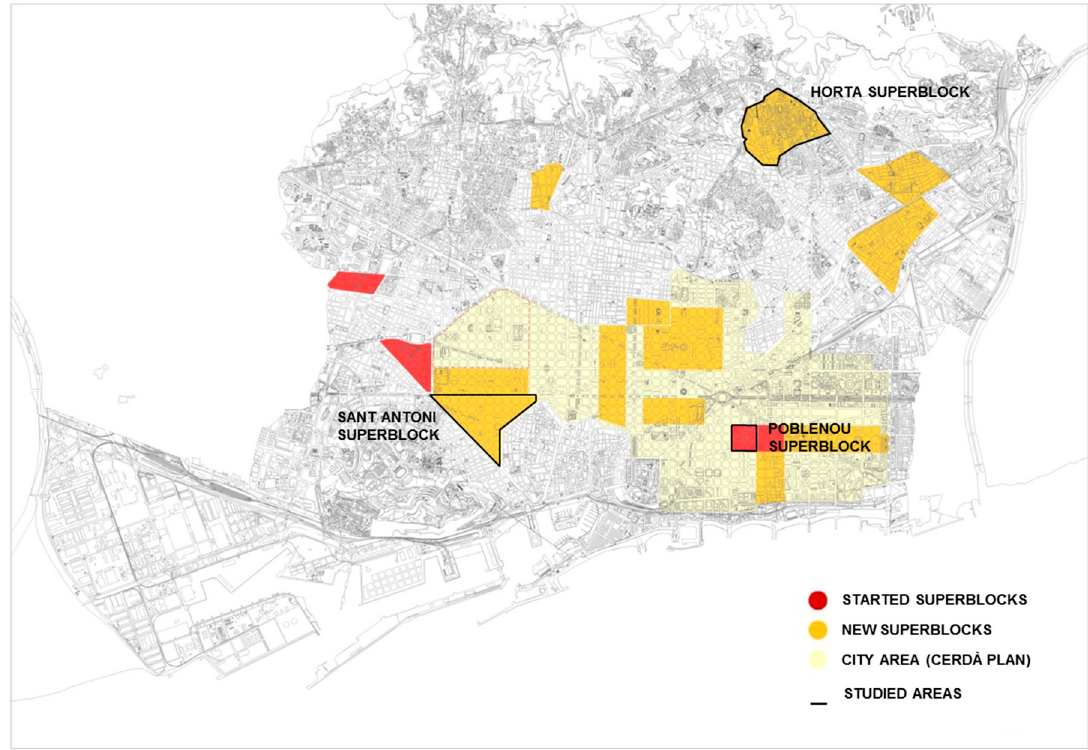
Figure 1. Barcelona superblocks, horizon 2017–2019. Source: Adapted from City-level implementation plan, horizon 2017–2019 in [11].